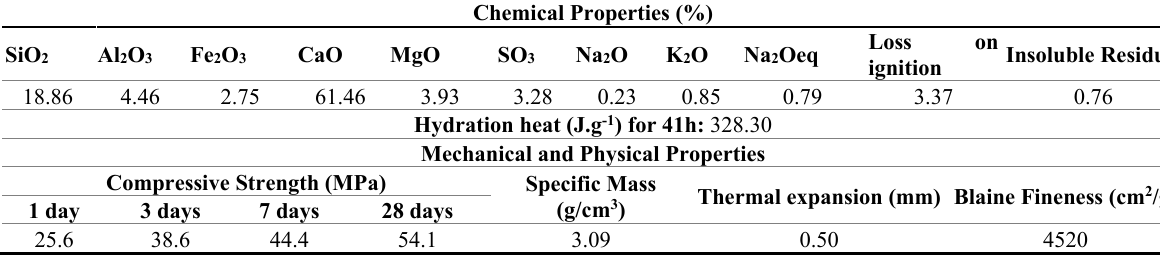
Table 1. Properties of the high early strength Portland cement, ASTM Type III.